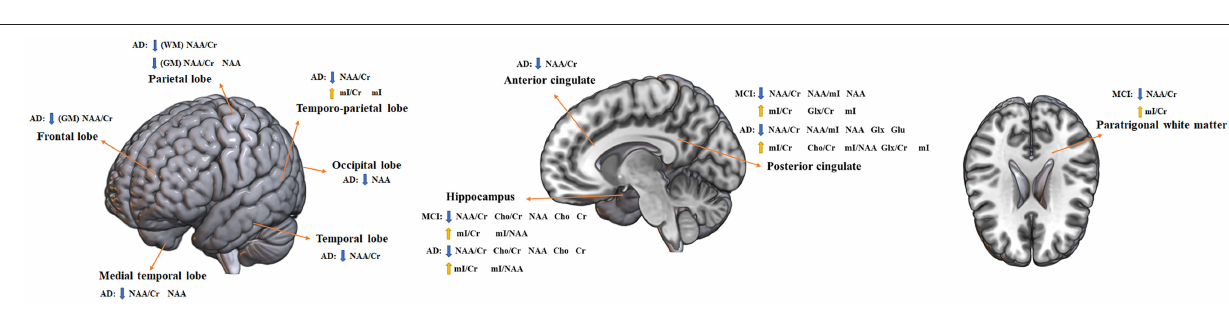
a comparison in the changes between 83 AD patients and 70 healthy control subjects, and 3 studies (Lim et al., 2012; Guo et al., 2016; Huang et al., 2017) were conducted to observe the differences of metabolites in 83 AD patients and 66 MCI